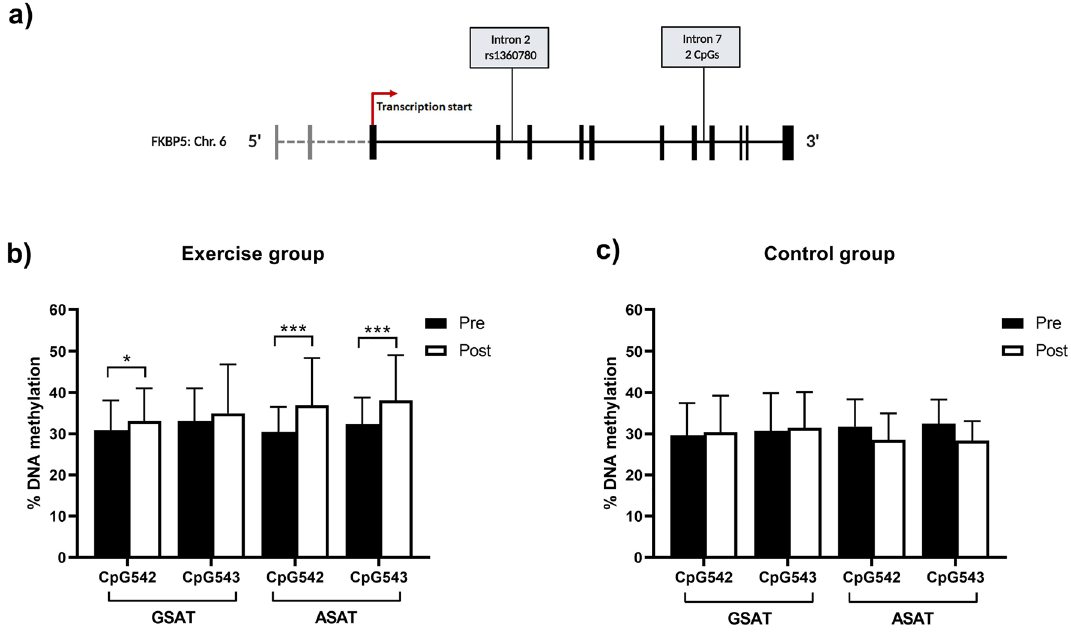
Figure 1. ( a ) Schematic diagram of the FKBP5 gene, illustrating the rs1360780 SNP and CpG542/3 sites in introns 2 and 7, respectively. Pyrosequencing analysis of percentage methylation at FKBP5 CpG542 and CpG543 in gluteal adipose tissue (GSAT) and abdominal adipose tissue (ASAT) in exercise (n = 19) ( b ) and control (n = 12) ( c ) participants pre- and post-intervention. Data represented as mean ± SD, * p < 0.05, *** p < 0.001.